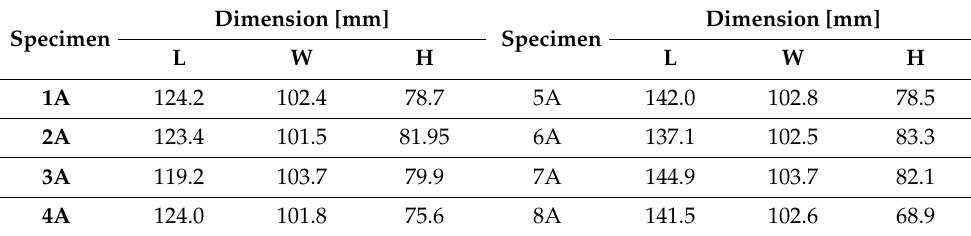
Table 2. The original specimen’s physical properties.